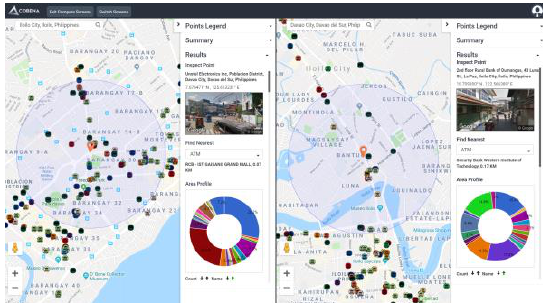
Figure 5. Screens compared side-by-side, typically used when analyzing two locations or